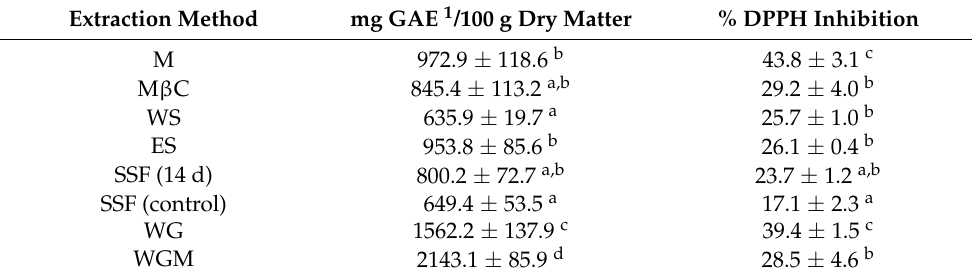
Table 1. Total phenol content and antiradical activity in the avocado peel extract obtained by different extraction